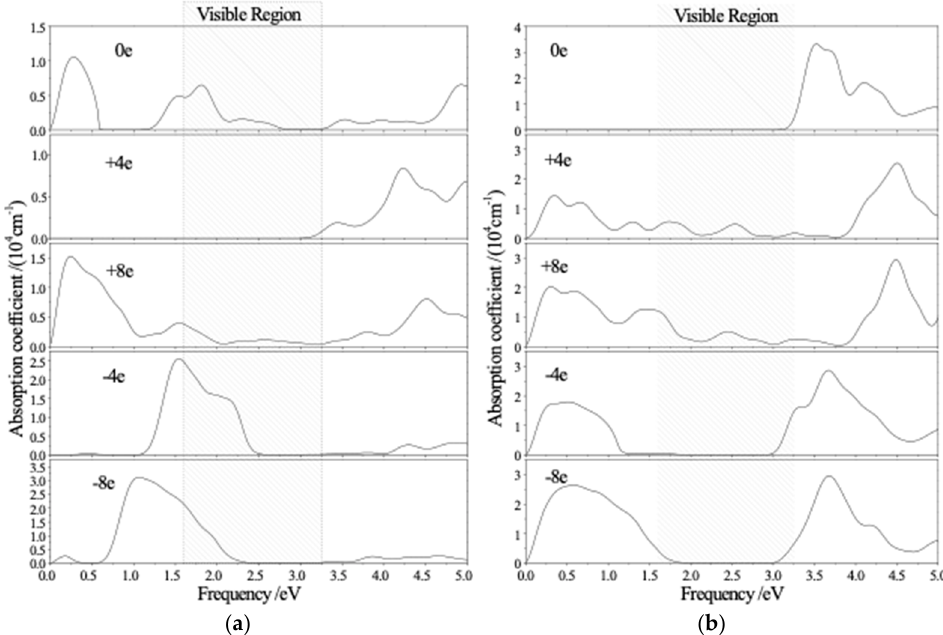
Figure 6. The calculated optical absorption spectra of ( a ) aAg 0.29 Li 0.71 -LSX and ( b ) cAg 0.29 Li 0.71 -LSX for the unpolarized light incident along [001] crystallographic direction, under different charge loading ( − 8e~+8e per unit cell).